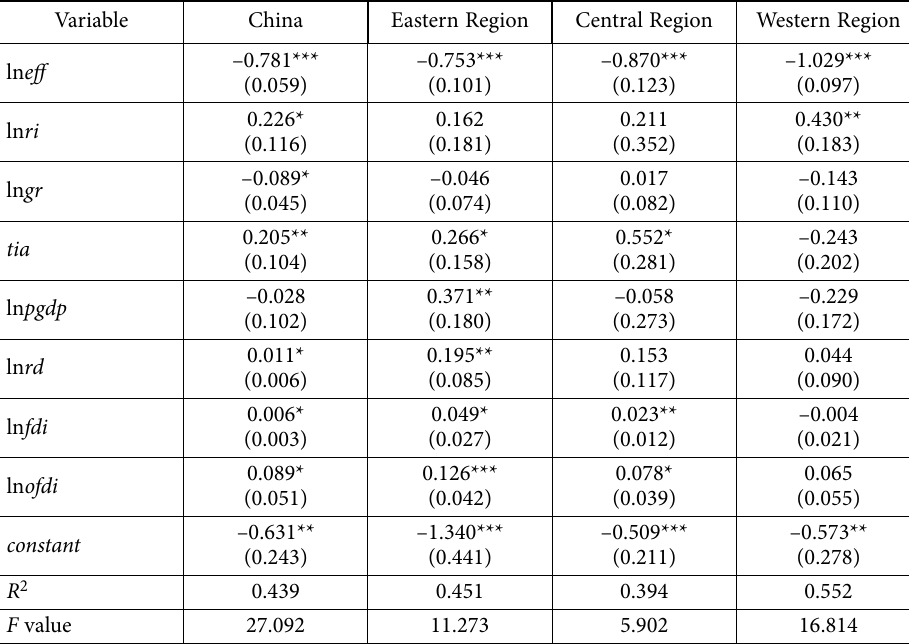
Table 3. Regression result of conditional convergence of environmental efficiency (source: The data in the table are calculated by the software of STATA) Variable